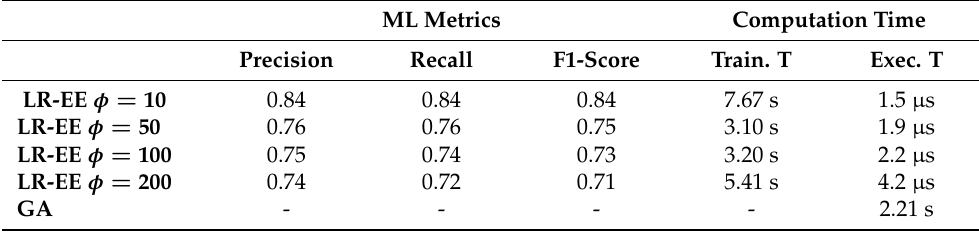
Table 1. Machine Learning metrics for LR-EE and